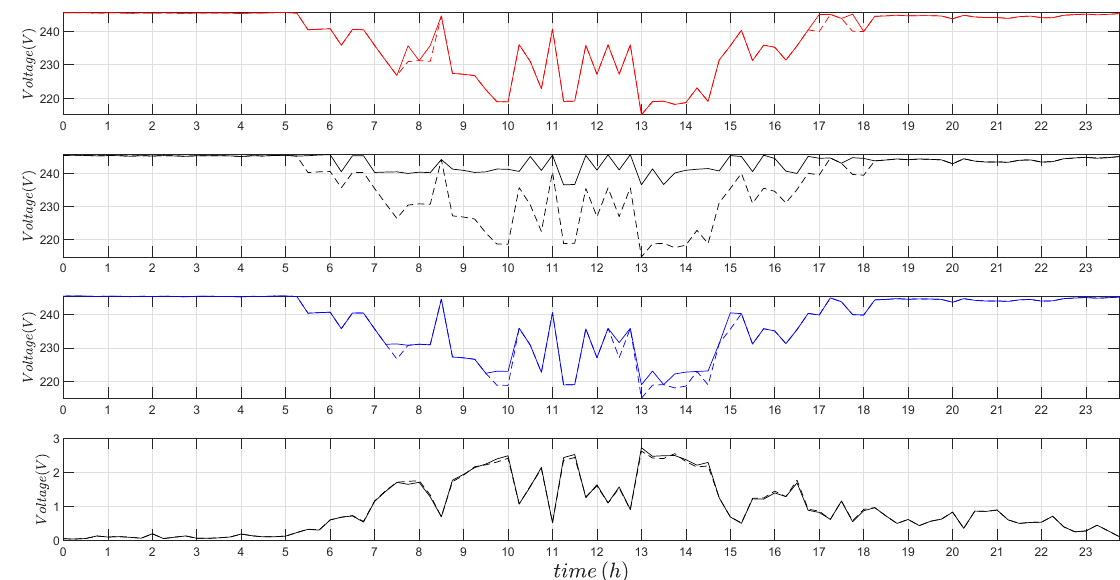
Figure 13. Phase-neutral voltage evolution for bus R1 when considering a 1P-OLTCTS or 3P-OLTCTS (dashed lines) for phases a, b, and c and neutral